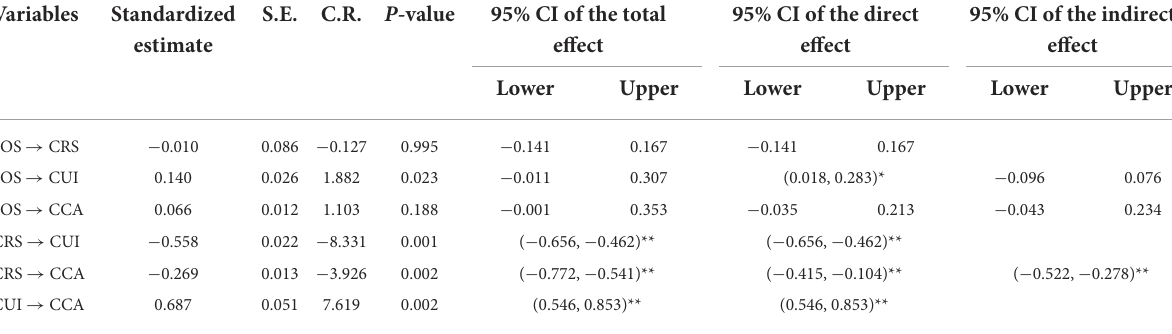
TABLE 3 The standardized total, indirect and direct effects of the adjusted hypothetical model.